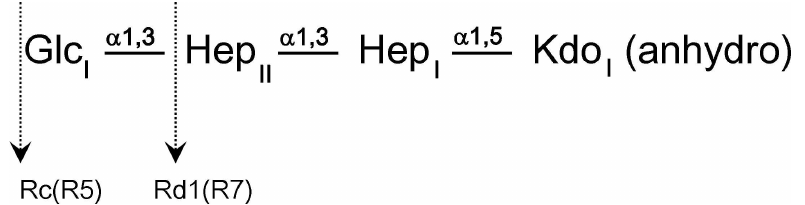
Fig 2. Structure of the product of mild acid hydrolysis of S . enterica Minnesota rough mutants R5 and R7. Glc: glucose; Hep: L-D-Heptose; Kdo: 3-deoxy-D-manno-oct-2-ulosonic acid.